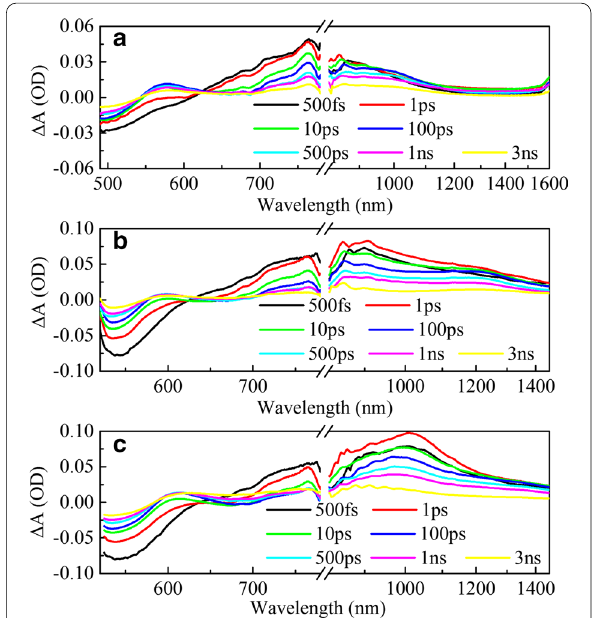
Fig. 4 Evolution-associated difference spectra (EADS) in VIS–NIR of HSD-A ( a ), HSD-B ( b ), HSD-C ( c )